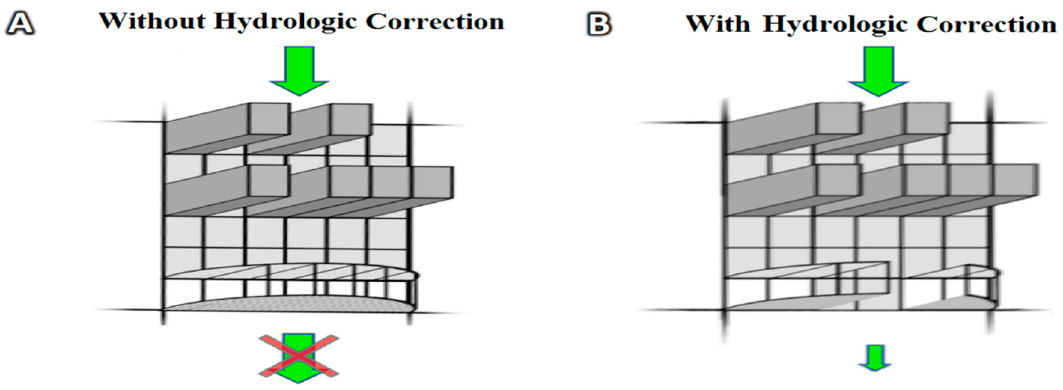
Figure 13. Conceptualization of macro-roughness features in an urban environment resolved within the street level inundation forecasts. In the example shown in ( A ), a bridge artificially obstructs flow from passing through to the hydrodynamic model grid cell below the one shown. With hydrologic correction provided by the citizen scientists via Catch the King ( B ) shows the grid opened, where a nearby flood contour can be extracted and applied to translate the inundation underneath the bridge and open flow to the opposite side, no longer impeding fluid flow.